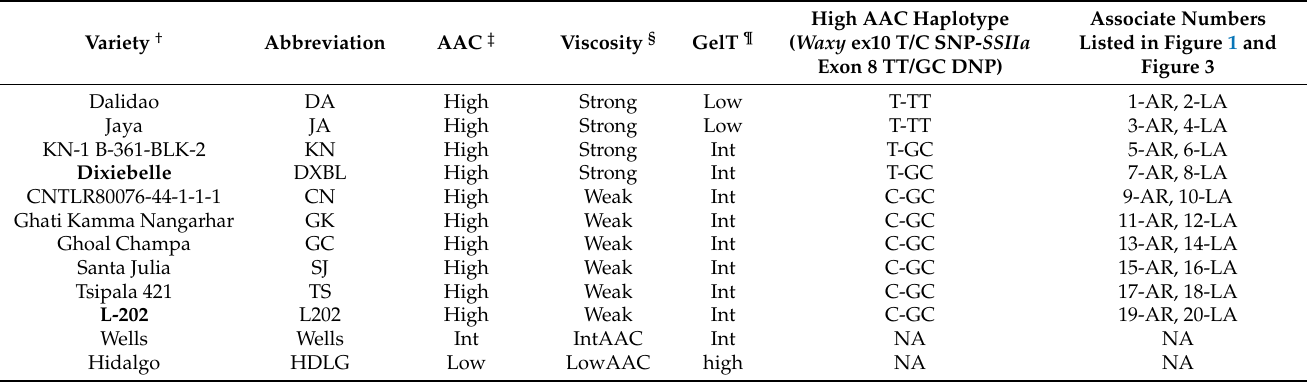
Table 1. Rice varieties and their predicted classes of apparent amylose, viscosity and gel temperature (GelT) based on Waxy exon 10 single nucleotide polymorphism (SNP) and SSIIa exon 8 dinucleotide polymorphism (DNP).